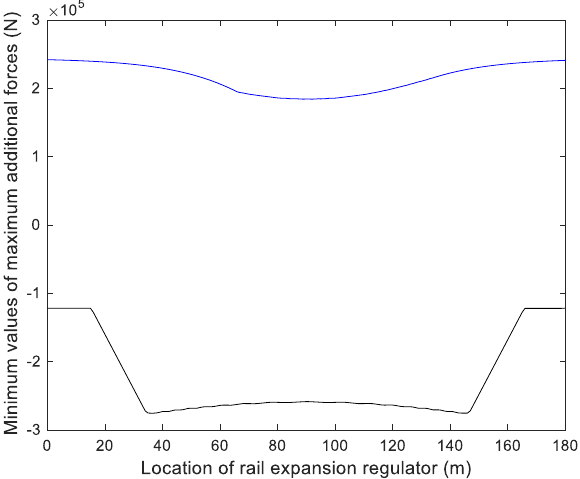
Figure 6. The curves of the minimum values of the maximum additional forces of rail changing with the location of RER for the length of 180 m of a continuous